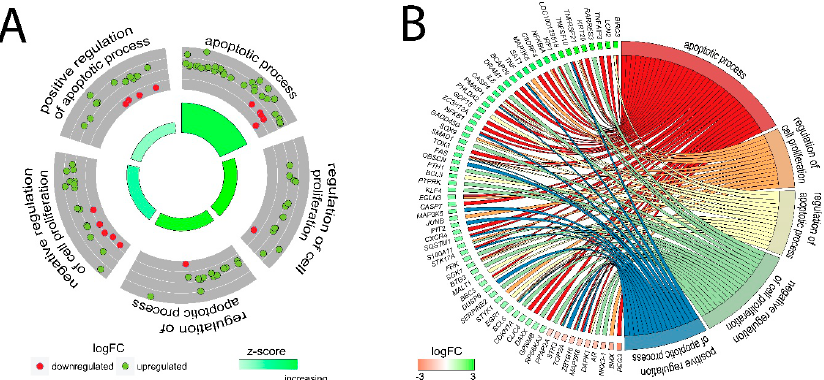
Figure 5. Detailed analysis of five enriched gene ontological groups involved in proliferation/apoptosis. ( A ) The circular scatter plots of differentially expressed genes involved in specific GO terms (positive regulation of apoptotic process, apoptotic process, regulation of cell proliferation, regulation of apoptotic process, negative regulation of cell proliferation). Each dot represents a single gene whose expression is increased (green) or decreased (red) due to LEP action. Positive value of Z-score mapped on a red colour scale was presented inside the graph. ( B ) Circos plots with interdependence between selected GO terms and their genes. Symbols of DEG are presented on the left side of the graph with their fold change values, mapped by colour scale (green = higher expression; red = lower expression). Gene involvement in the GO terms was determined by coloured connecting lines.